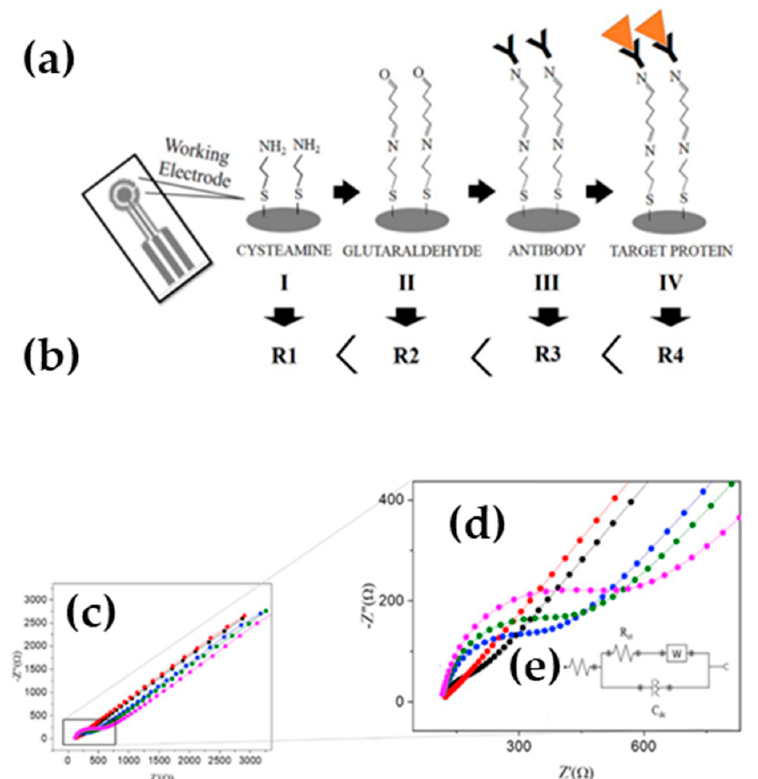
Figure 19. ( a ) Preparation scheme of the biosensor showing the steps of construction of the self-assembled monolayer, immobilization of the antibody and immunocomplex formation; (b) scheme showing increased resistance to electron transfer as further modifications are made on the working electrode surface; ( c, d ) Nyquist diagrams of ( ● ) platinum electrode (Pt), ( ● ) Pt-cysteamine, ( ● ) Pt-cysteamine-glutaraldehyde, ( ● ) Pt-cysteamine-glutaraldehyde-antibody and ( ● ) Pt-cysteamine-glutaraldehyde-antibody-PARK7/DJ-1 protein; (e) equivalent circuit used for simulation of the experimental data, in the presence of redox couples. Reprinted with permission from reference [50]. Copyright © 2020 Elsevier